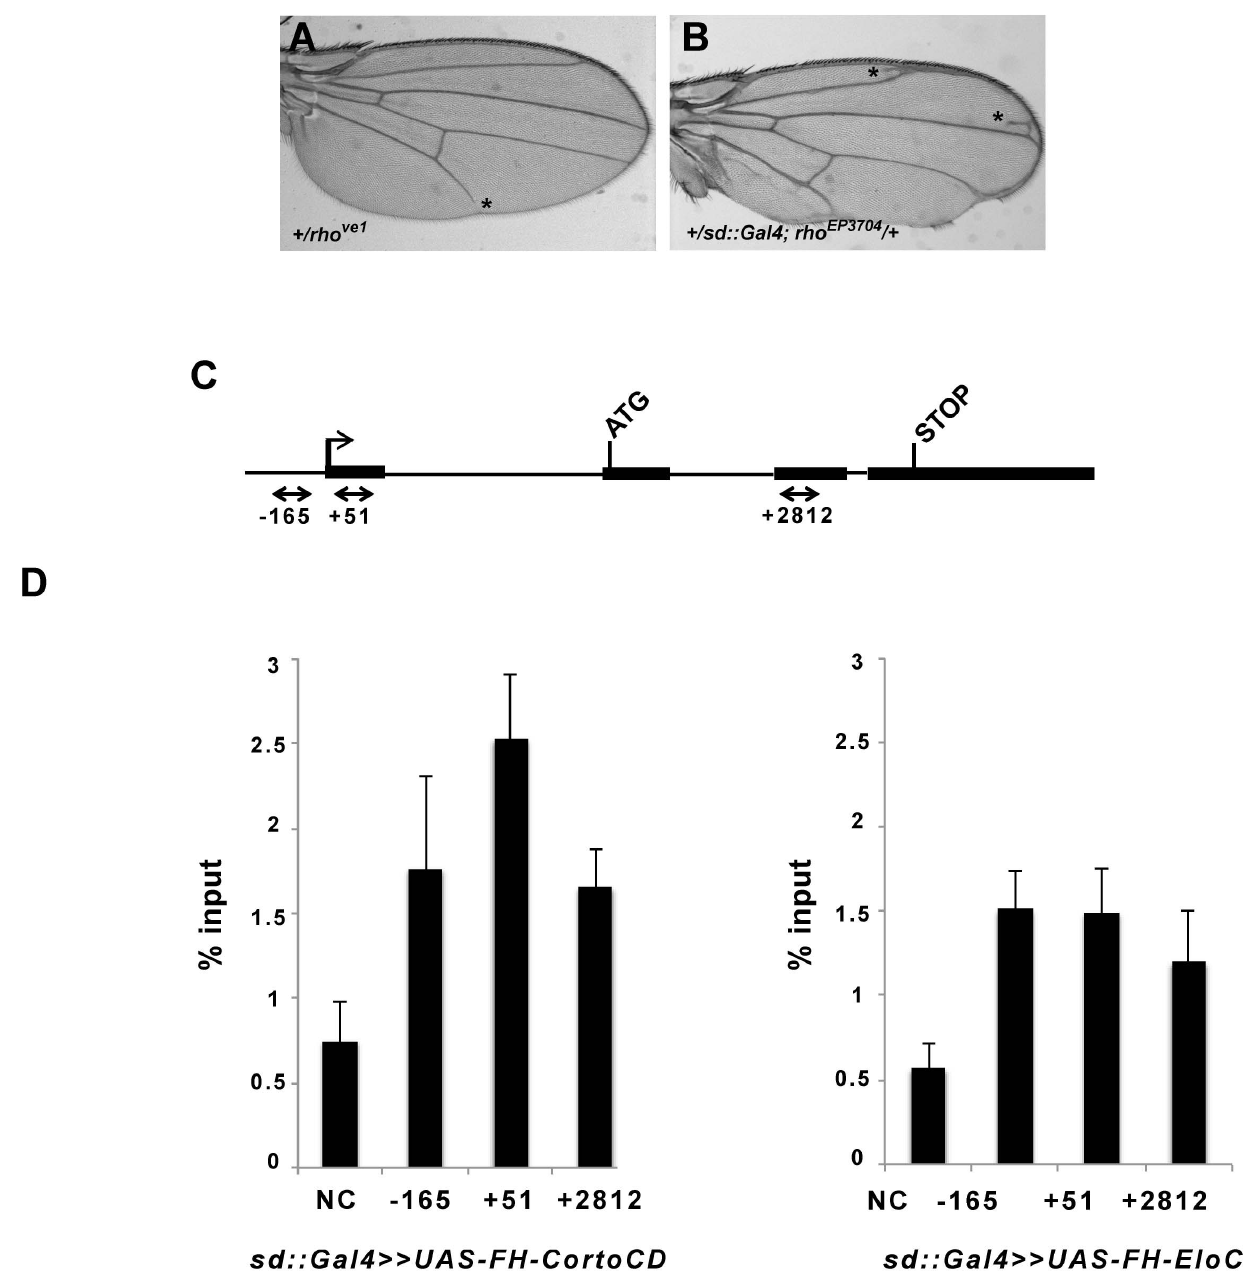
Figure 7. EloC and Corto bind rho in wing imaginal discs. (A, B): Wing phenotypes induced by rho loss-of-function (A) or over-expression (B). Asterisks mark truncated L5 (in A) or ectopic veins (in B). (C): Schematic structure of rho with exons represented by boxes and introns by lines. Black arrows show primer pairs used for ChIP experiments. (D): Binding of Corto chromodomain (FH-CortoCD) and EloC (FH-EloC) on rho . For each genotype, the mean of two independent experiments is shown. Error bars correspond to standard deviations.